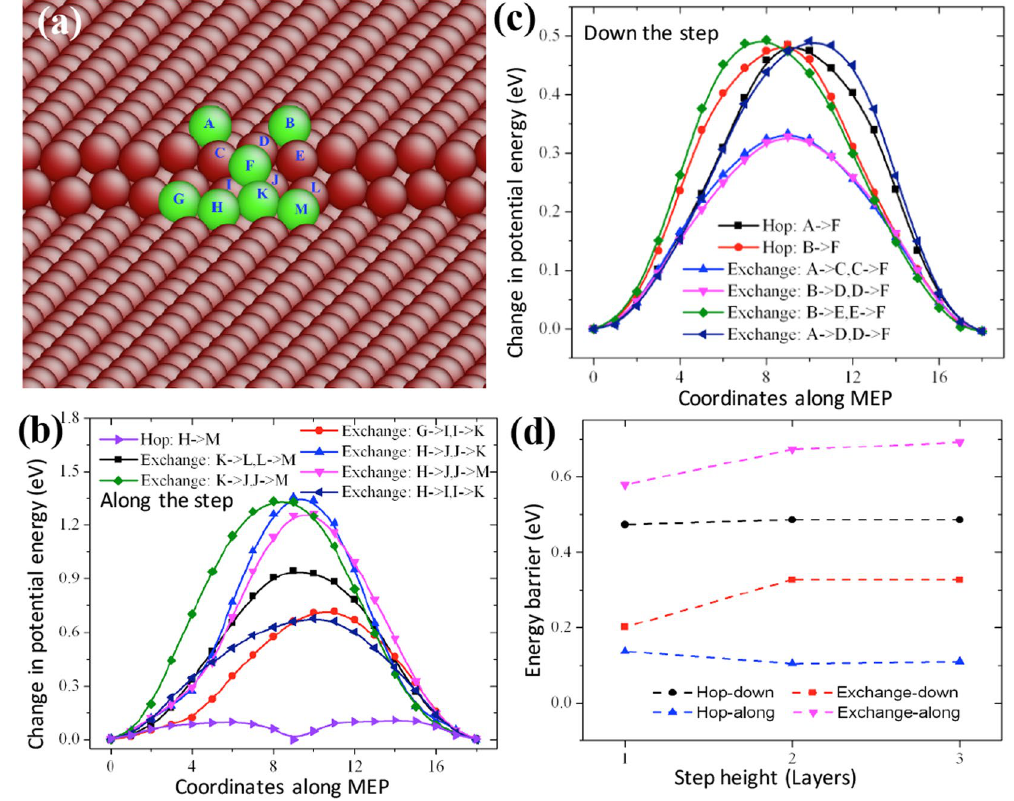
Figure 5. ( a ) Atomic structure of a 2-layer step on surface ( ¯ 1101 ). ( b ) Change in potential energy with respect to different diffusion paths as an adatom diffuses along the step. ( c ) Change in potential energy with respect to different diffusion paths as an adatom diffuses down the step. ( d ) Variation of kinetic energy barriers as a function of the step